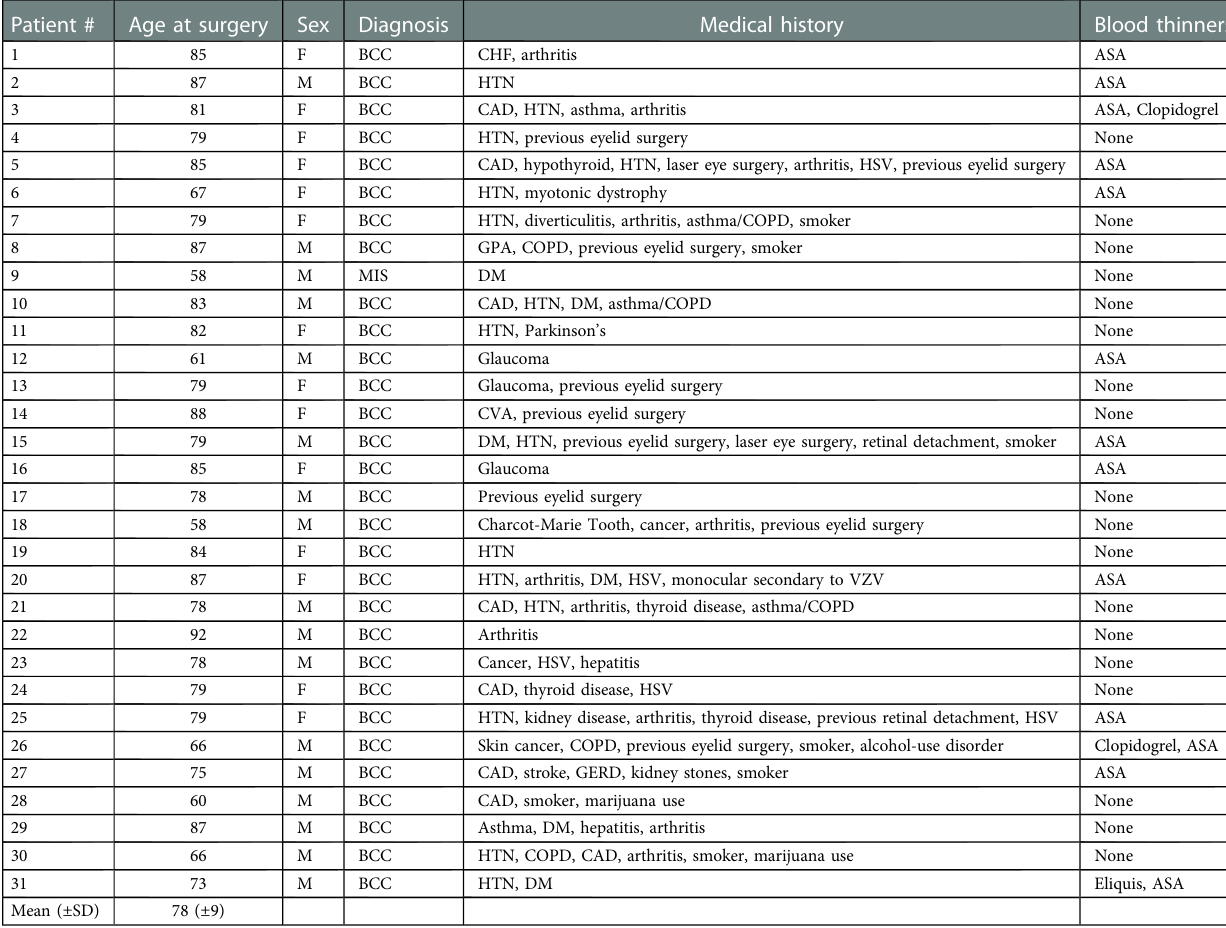
Patients listed in chronological order of surgery. BCC, basal cell carcinoma; MIS, melanoma in situ; CHF, congestive heart failure; HTN, hypertension; CAD, coronary artery disease; GPA, granulomatosis with polyangiitis; COPD, chronic obstructive pulmonary disease; DM, diabetes mellitus; CVA, cerebral vascular accident; HSV, herpes simplex virus (cold sores); ASA,